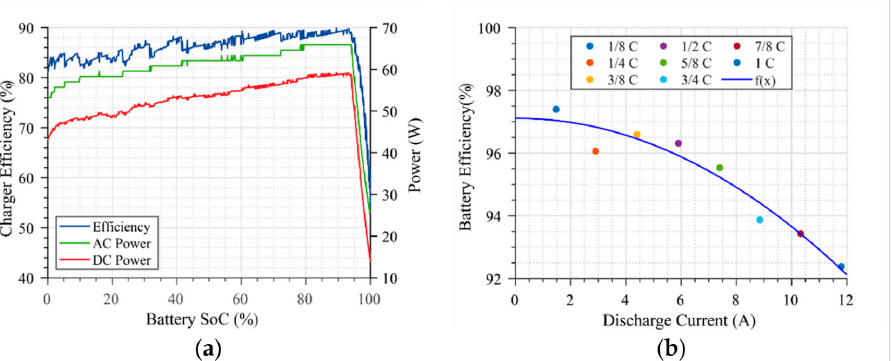
Figure 4. ( a ) Charger efficiency and power vs. battery state of charge (SoC). ( b ) Battery efficiency vs. discharge